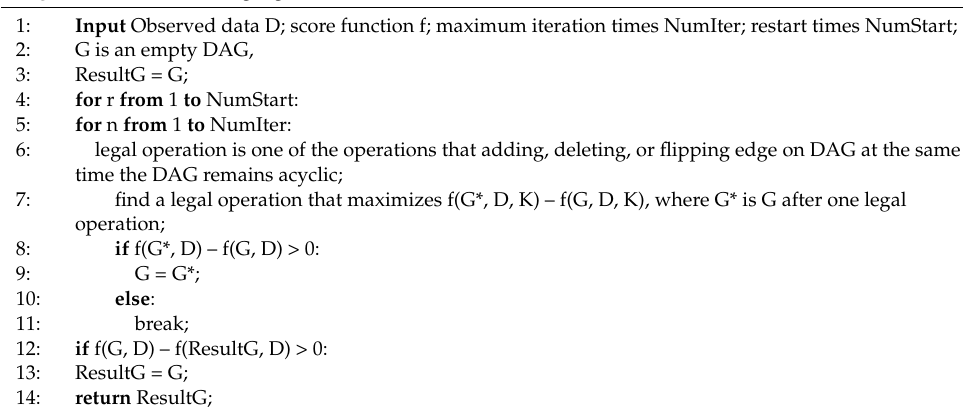
Algorithm 1 Hill–climbing